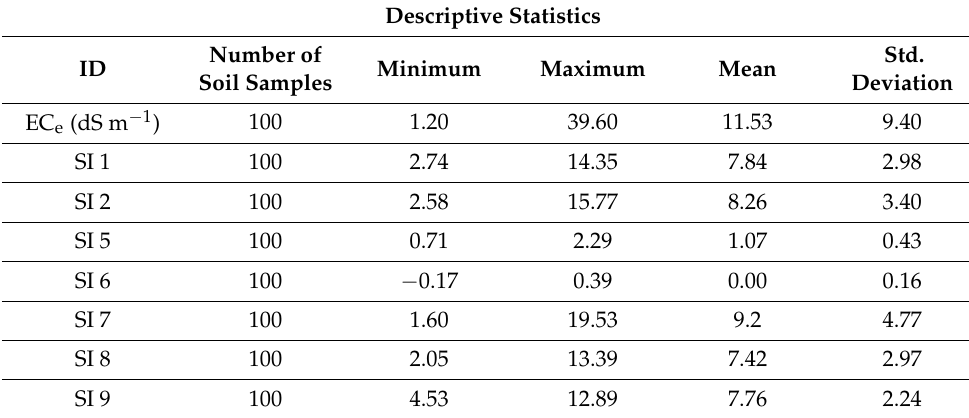
Table 3. Descriptive statistics of soil salinity indices and soil EC e